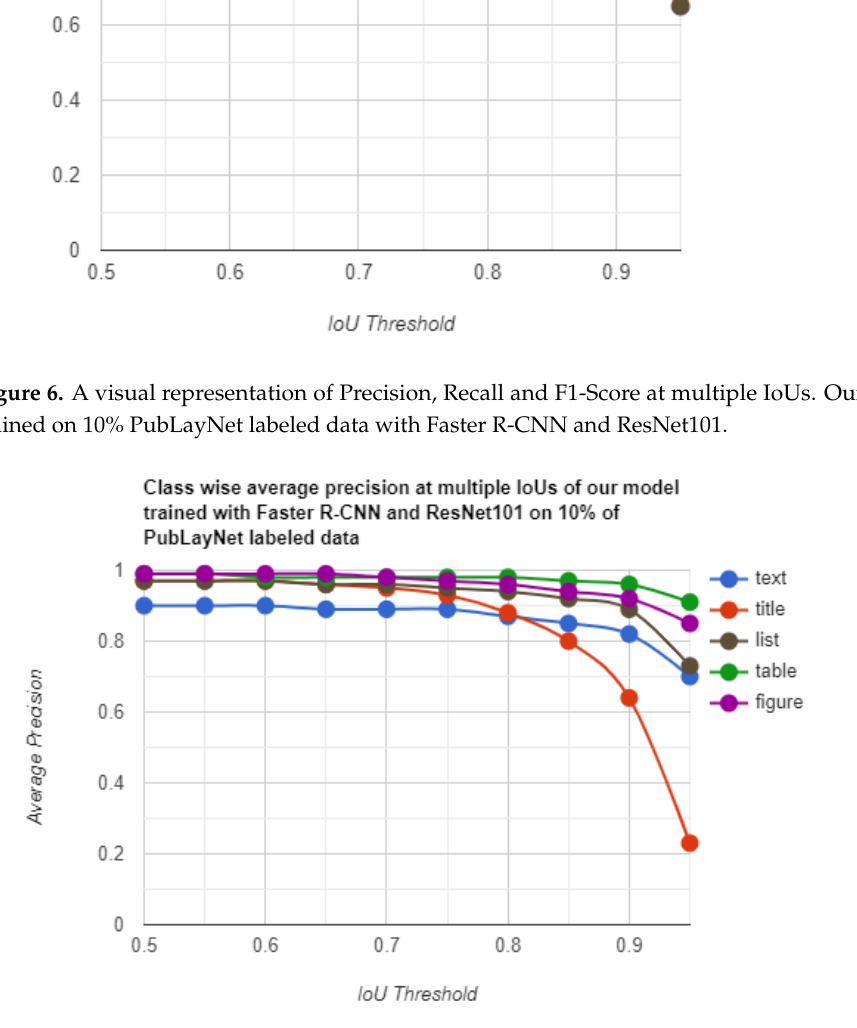
Figure 7. A label-wise visual representation of Precision at multiple IoUs. Our model is trained on 10% PubLayNet labeled data with Faster R-CNN and